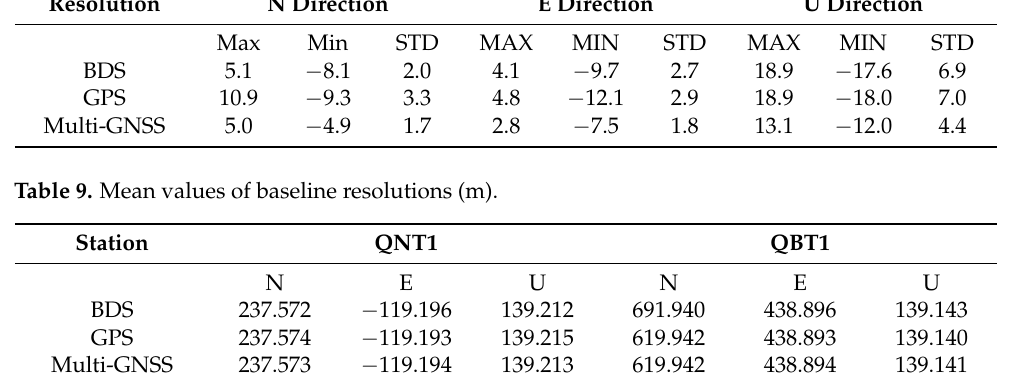
Table 8. The maximum, minimum errors and STD for different system combinations/mm.